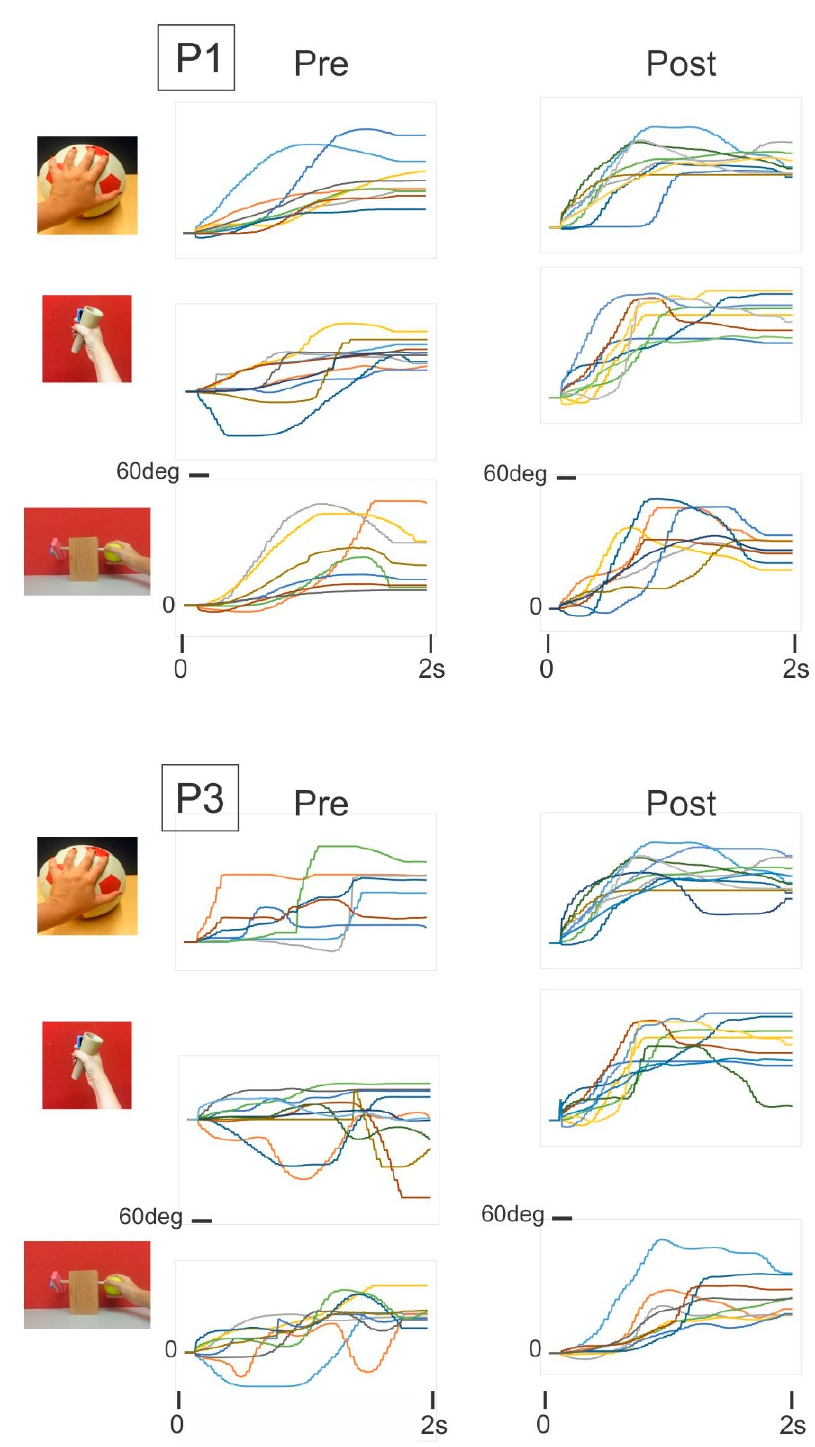
Figure 4. Game movement responses for three test object manipulation tasks of two children: pre- and post-intervention.